Question: Author a descriptive caption for the visualization shown.
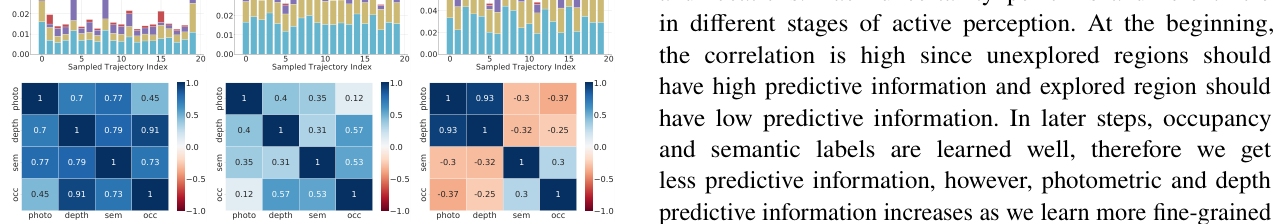
Answer: Top: Predictive information (Ipred) of the executed trajectories for the three different scenes. Middle: Ipred integrated along trajectories at the beginning, middle, and end of active perception for scene 3 (top right). Bottom: Correlation among the four types of Ipred at beginning, middle and end for scene 3 (top right).